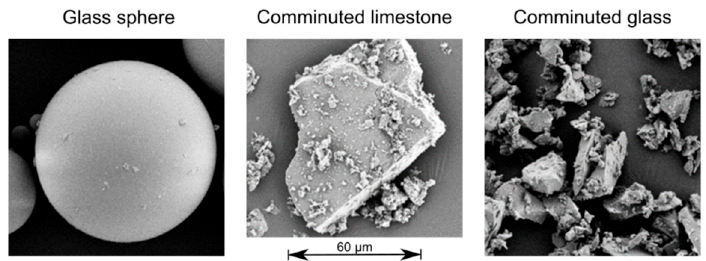
Figure 1. SEM images of the used materials showing a glass sphere ( left ), limestone particle ( center ), and comminuted glass ( right ). The scale applies to all images.